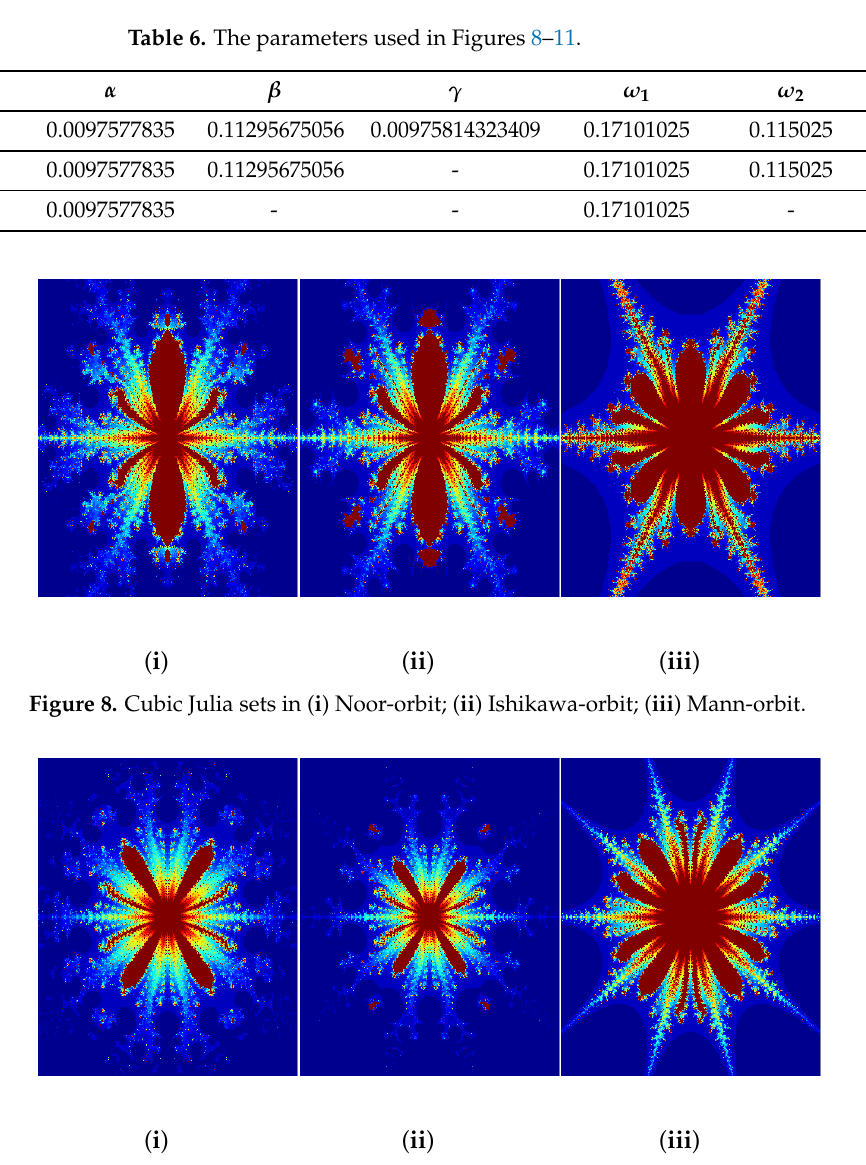
Figure 9. Quintic Julia sets in ( i ) Noor-orbit; ( ii ) Ishikawa-orbit; ( iii ) Mann-orbit.